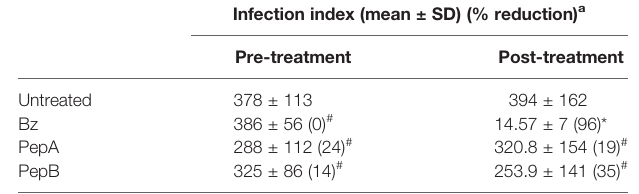
TABLE 2 | Activity of peptide A (PepA), peptide B (PepB), and benznidazole (Bz) on in-vitro infection of peritoneal mouse macrophages (PMM) by Trypanosoma cruzi (Y strain) submitted to pre- and posttreatment protocols.